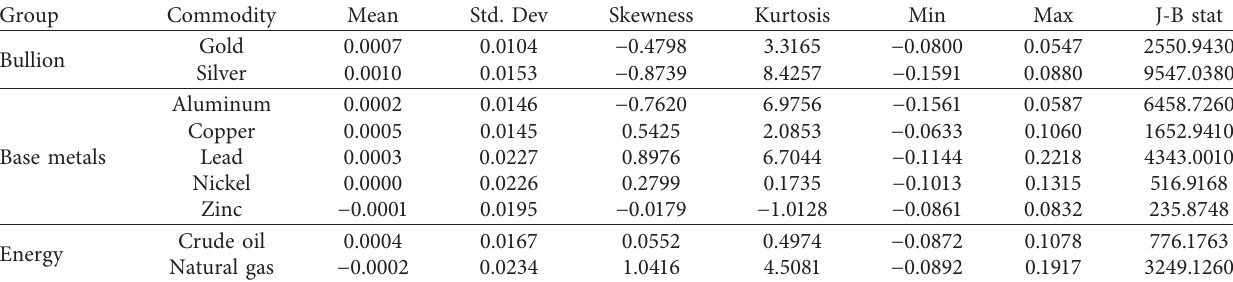
Table 5: Descriptive statistics of selected commodities for futures return.